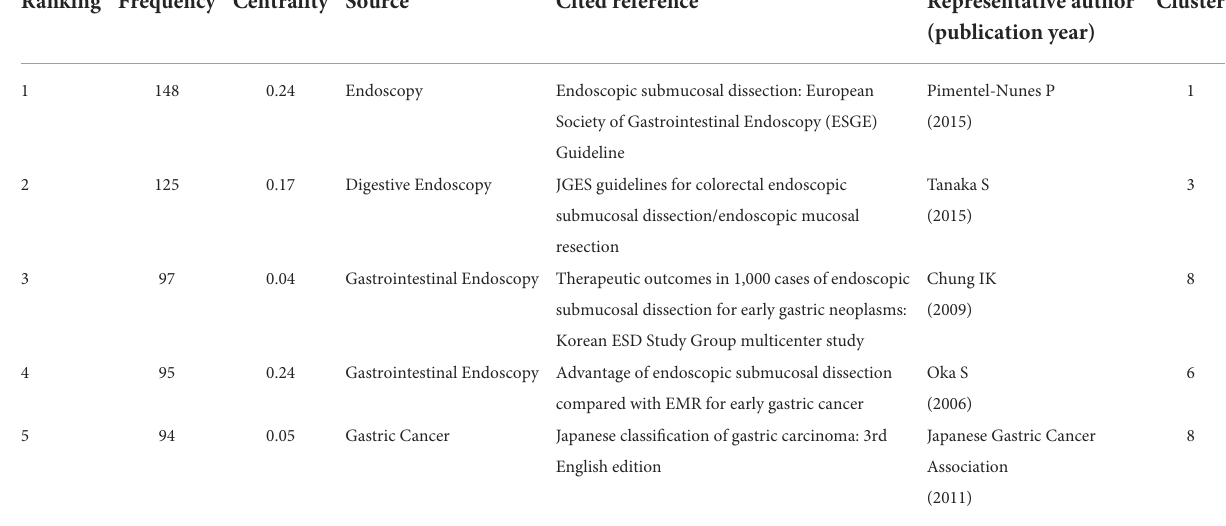
TABLE 5 Top 5 co-citation references related to ESD, 2006-2020. Ranking Frequency Centrality